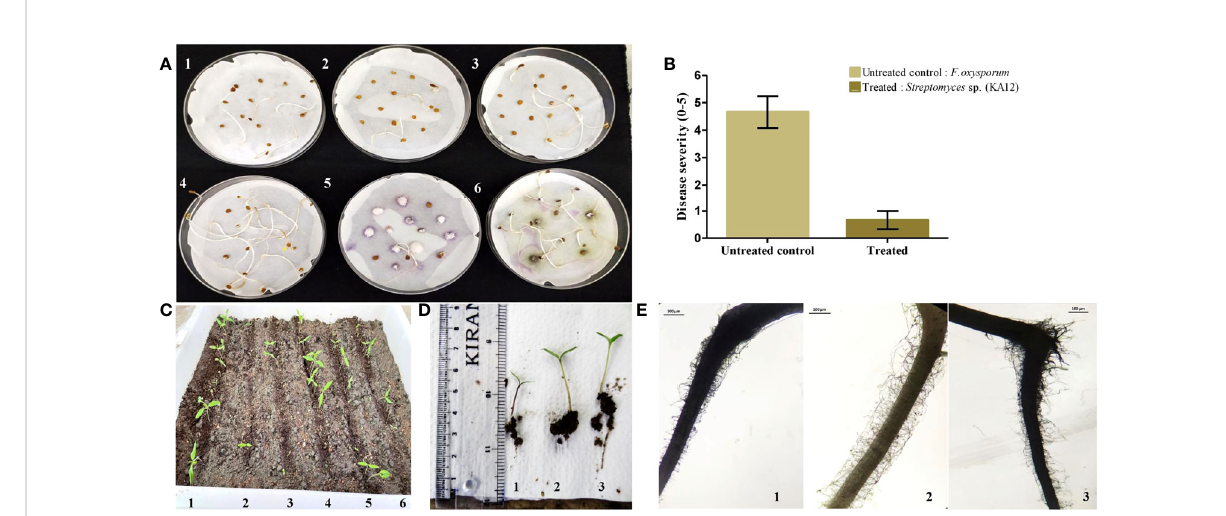
FIGURE 6 Evaluation of induced systemic resistance and seed germination. (A) . Seed germination plate assay (1,2,3) Control. Non-bacterized tomato seeds, (4) KA12 bacterized seeds, (5) F . oxysporum inoculated seeds, (6) KA12 bacterized seeds, and F . oxysporum inoculated (B) Degree of disease severity in control and inoculated seeds. (C) In-planta seed germination assay. (1) Bacterized tomato seeds, (2, 3, 5, 6) non-bacterized control seeds, (4) F . oxysporum inoculated seeds, (D) growth after 14 days of germination, (1) un-inoculated control, (2) KA12 and F . oxysporum inoculated, (3) KA12 inoculated. (E) Stereomicroscopic visualization of root hairs after 14 days of seed germination (1) Un-inoculated control (2) KA12 inoculated (3) Inoculated with KA12 and F . oxysporum . Scale 100 m